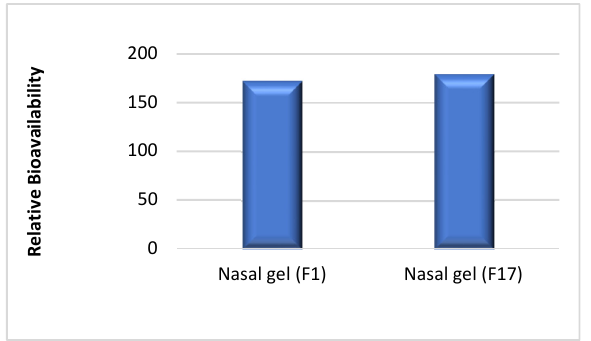
Figure 3. Relative bioavailability of in situ gel F1 to the commercial tablet in comparison to the relative bioavailability of F 17 to the same tablets.